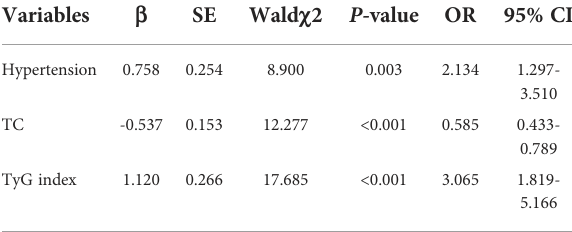
TABLE 5 Multivariate logistic regression analysis of risk factors for AF in non-diabetic